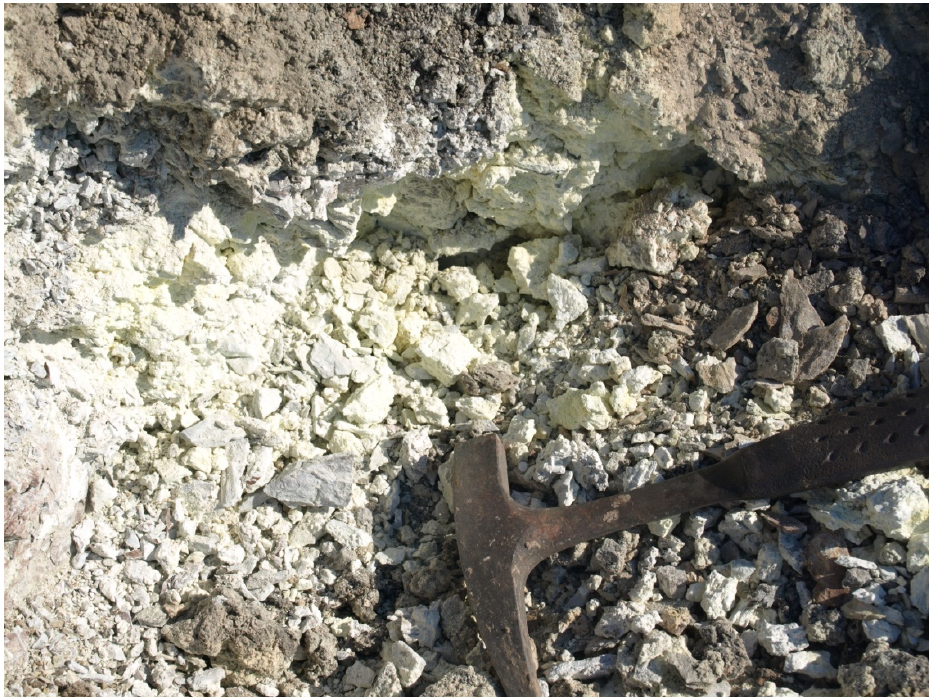
Figure 2. Freshly exposed sulfate crust composed mainly of godovikovite, Rydułtowy. Notice the yellowish color that fades quickly.